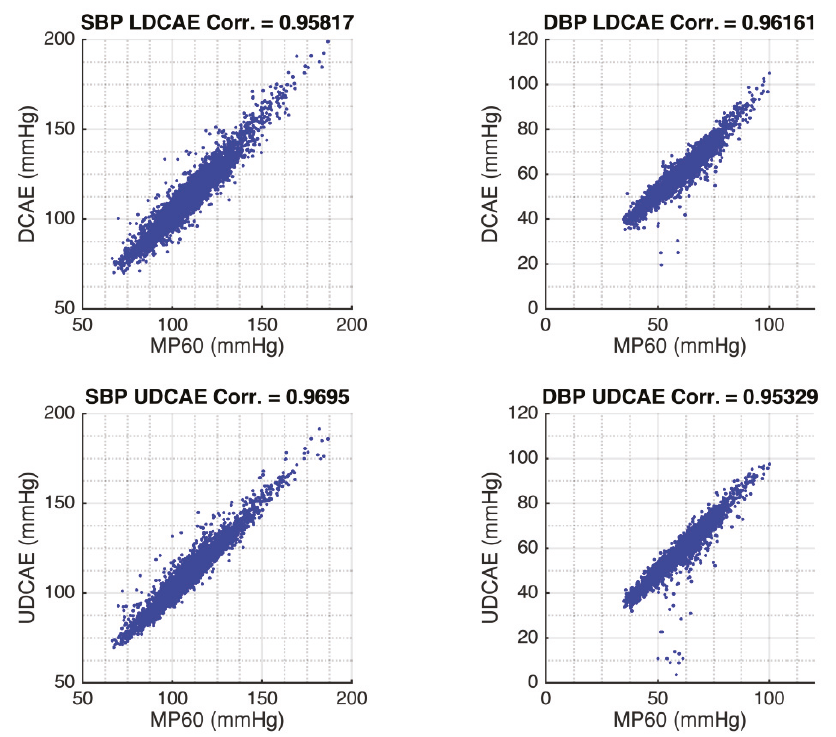
Figure 4. The Pearson’s linear correlation comparison between DCAE-based models and MP60 IntelliVue Patient Monitor.